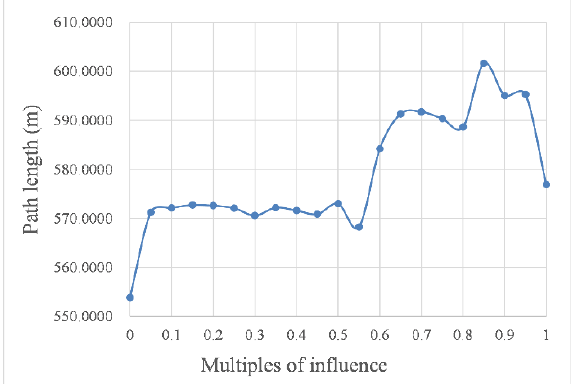
Figure 11. Path length affected by different intensities.